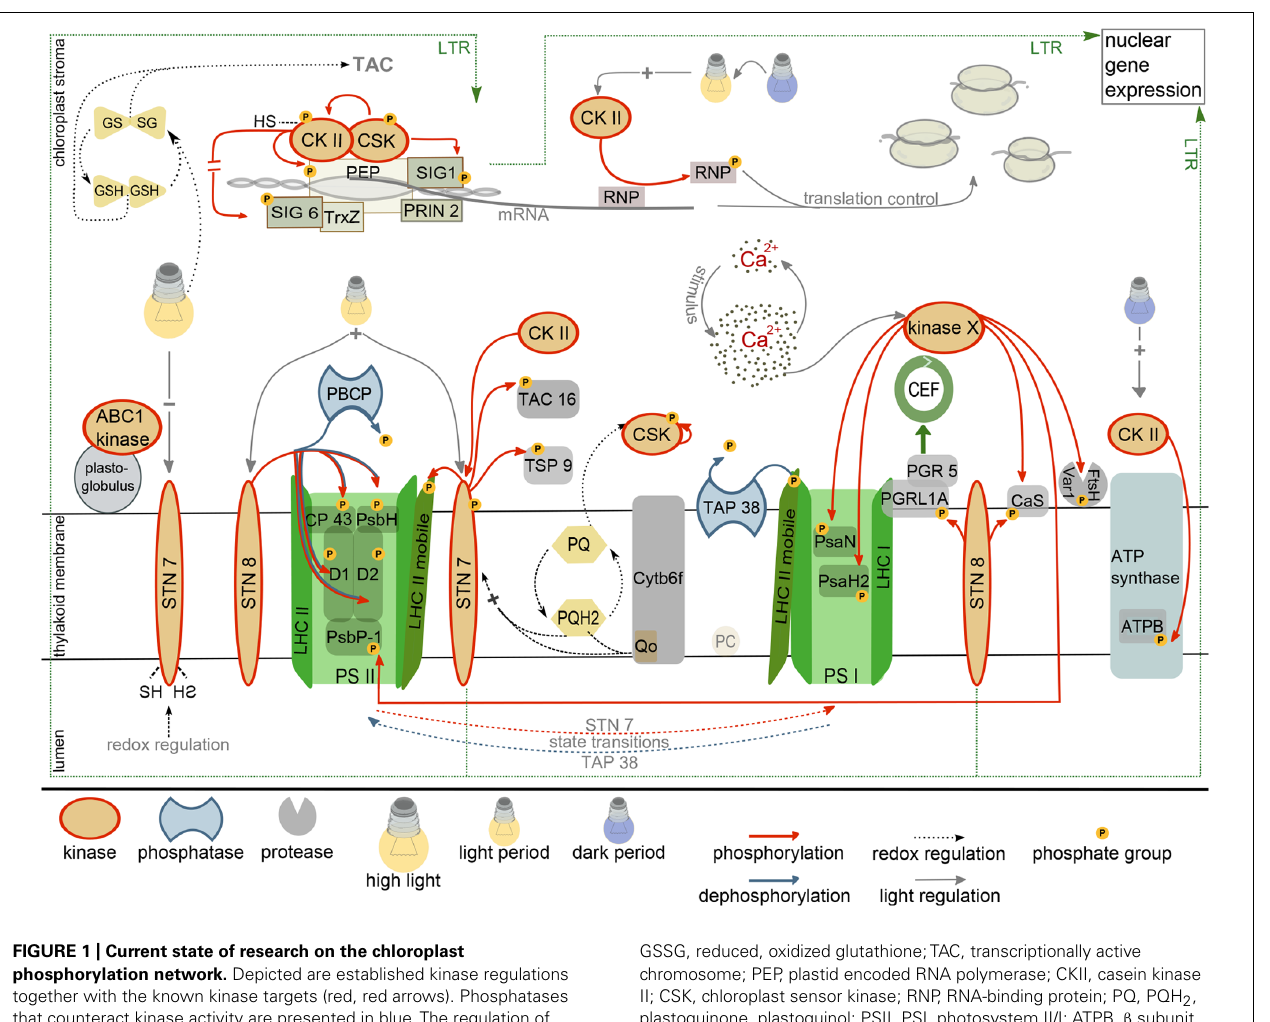
FIGURE 1 | Current state of research on the chloroplast phosphorylation network. Depicted are established kinase regulations together with the known kinase targets (red, red arrows). Phosphatases that counteract kinase activity are presented in blue.The regulation of the long-term-response (LTR) by kinases of the thylakoid membrane system involves changes in nuclear gene expression and is marked with a dashed line. For further details see main text. CEF, cyclic electron flow; GSH,